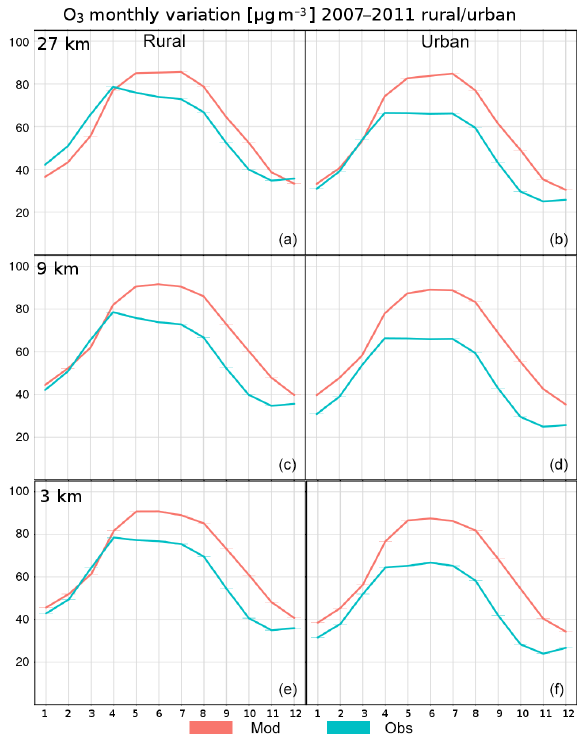
Figure 5. Comparison of monthly ozone values with measurements daily in µgm − 3 for rural (a, c, e) and urban background stations (b, d, f) for the three domains (27, 9 and 3km, from top to bottom): model (red) and observation